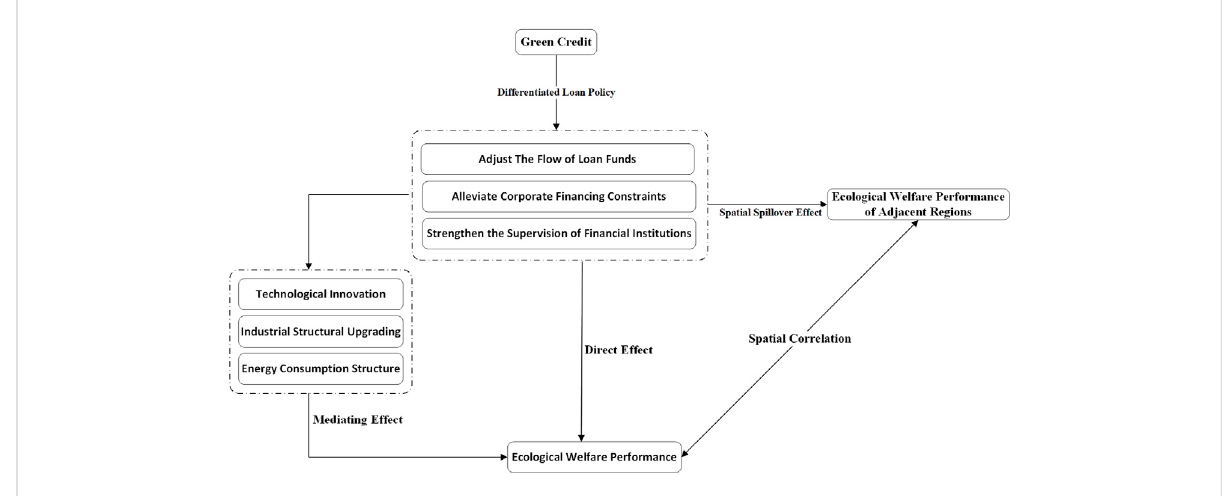
FIGURE 1 The effect mechanism of green credit on